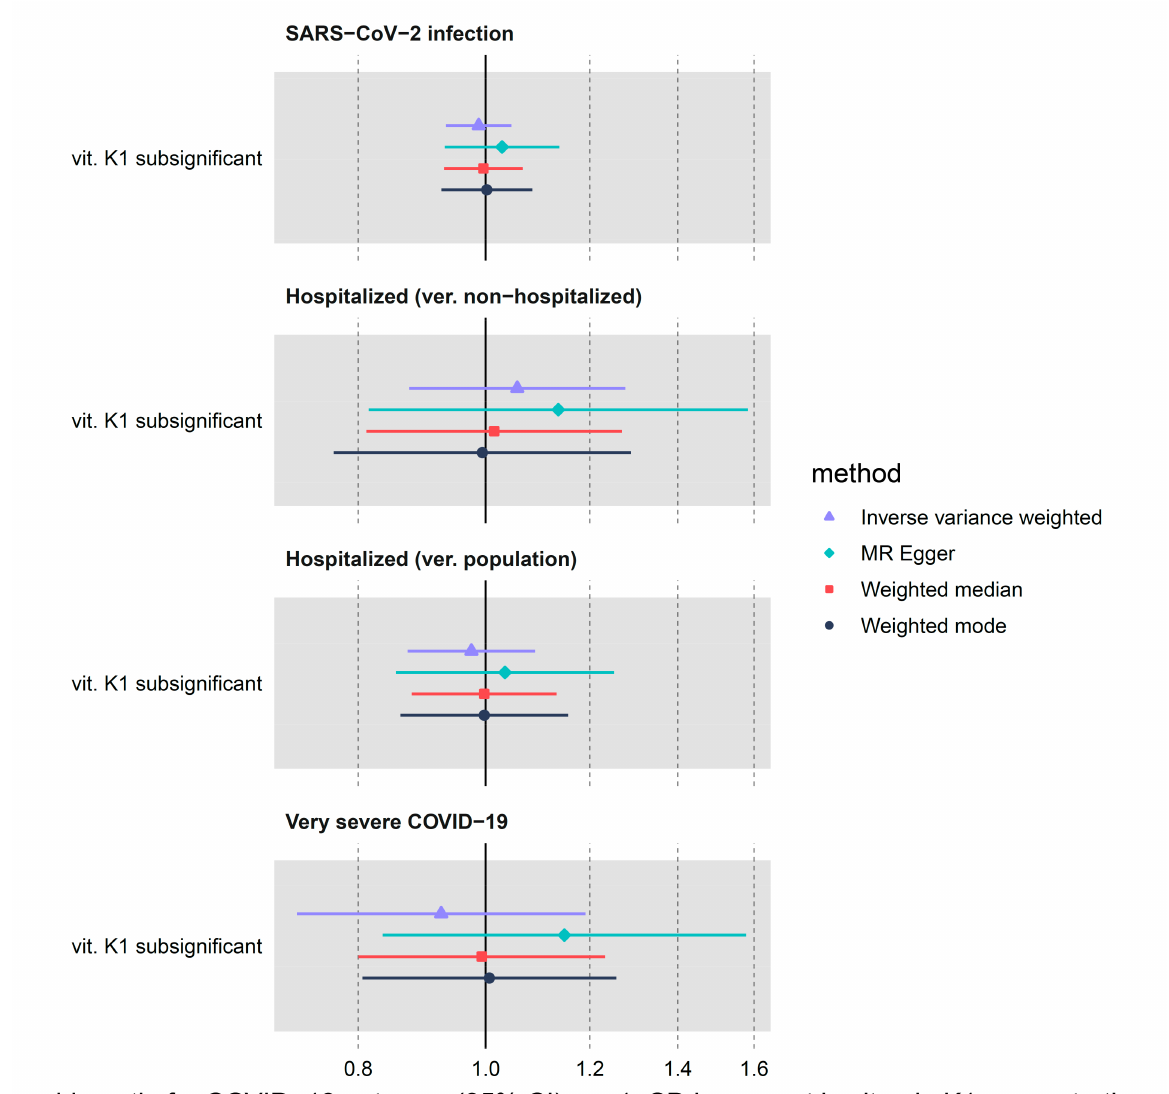
Figure 4. MR estimates for the effect of circulating vitamin K1 on three COVID-19 outcomes obtained using 4 different statistical methods. We only had access to instruments with sub-significant p -values < 5 × 10 − 5